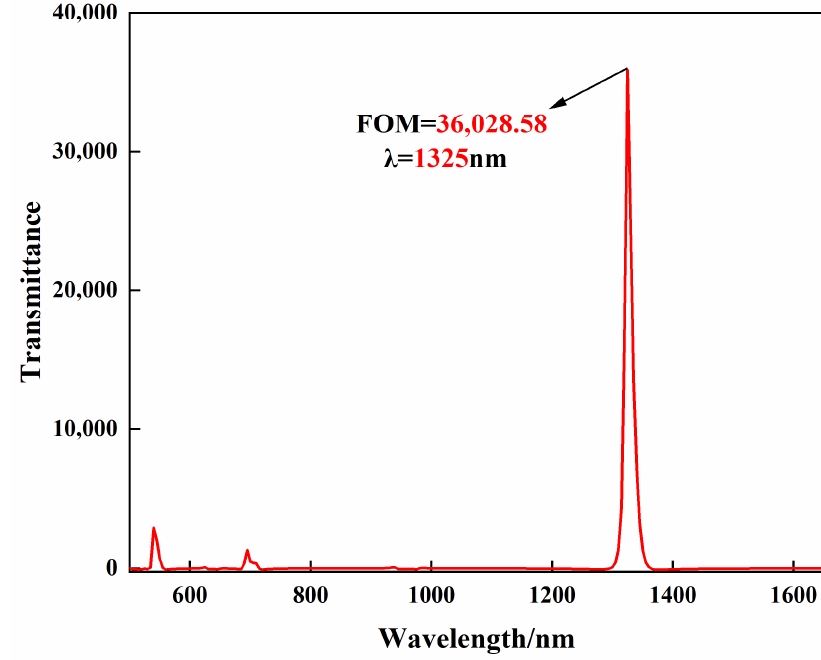
Figure 9. The FOM value of the